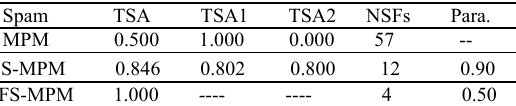
Table 5 TSAs and NSFs for Spam.